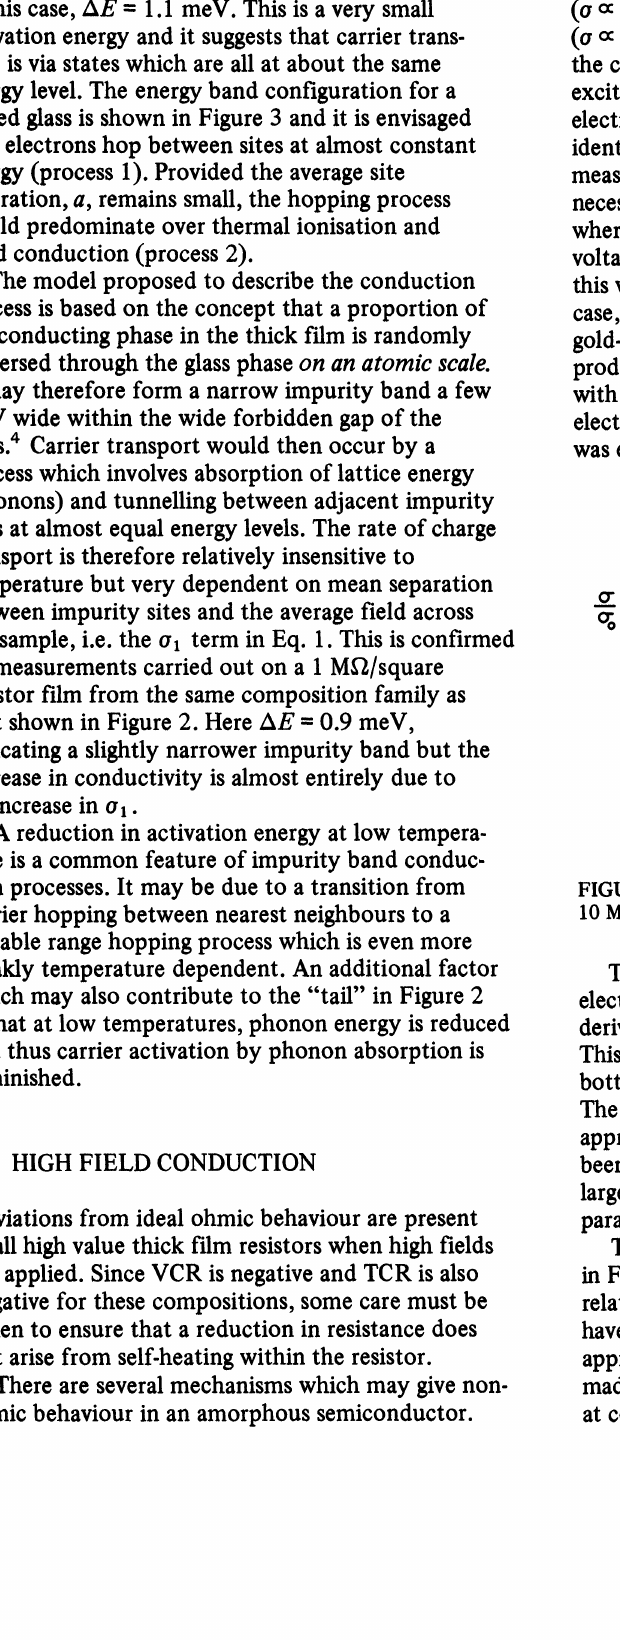
Variation of conductivity with field for 10 M[2/square